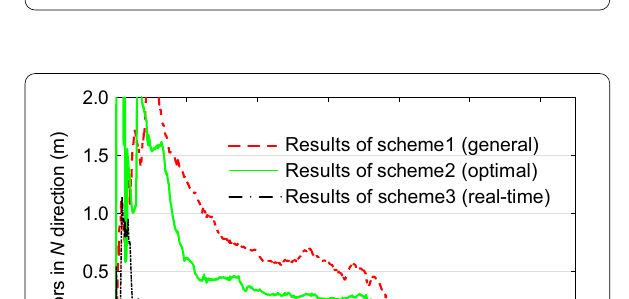
Fig. 16 Position errors in U direction